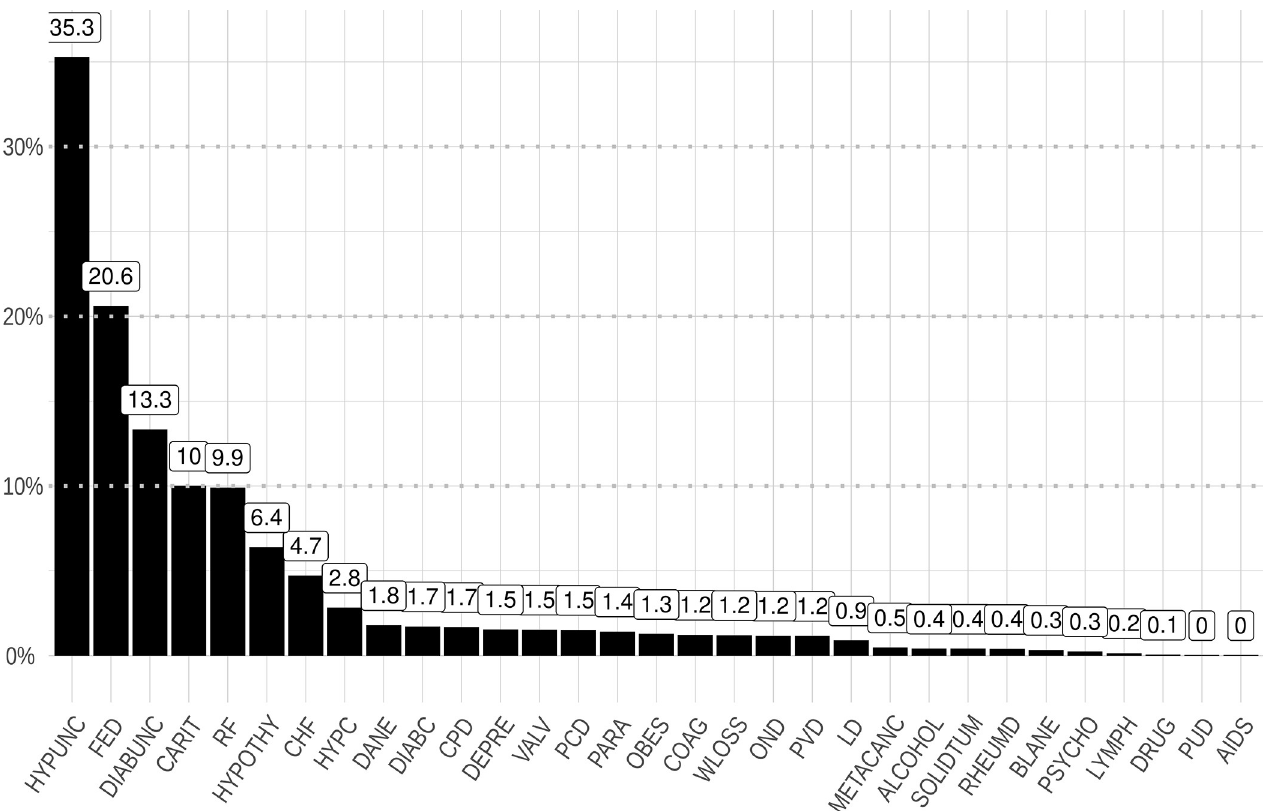
Fig 4. Relative frequencies of comorbidities in COVID-19 hospitalizations in Germany 2020. chf: congestive heart failure; carit: cardiac arrhythmias; valv: valvular disease; pcd: pulmonary circulation disorders; pvd: peripheral vascular disorders; hypunc: hypertension—uncomplicated; hypc: hypertension— complicated; para: paralysis; ond: other neurological disorders; cpd: chronic pulmonary disease; diabunc: diabetes -uncomplicated; diabc: diabetes- complicated; hypothy: hypothyroidism; ld: liver disease; pud: peptic ulcer disease- excluding bleeding; aids: AIDS/HIV; lymph: lymphoma; metacanc: metastatic cancer; solidtum: solid tumour: without metastasis; rheumd: rheumatoid arthritis/collaged vascular disease; coag: coagulopathy; obes: obesity; wloss: weight loss; fed: fluid and electrolyte disorders; blane: blood loss anaemia; dane: deficiency anaemia; alcohol: alcohol abuse; drug: drug abuse; psycho: psychoses; depre: